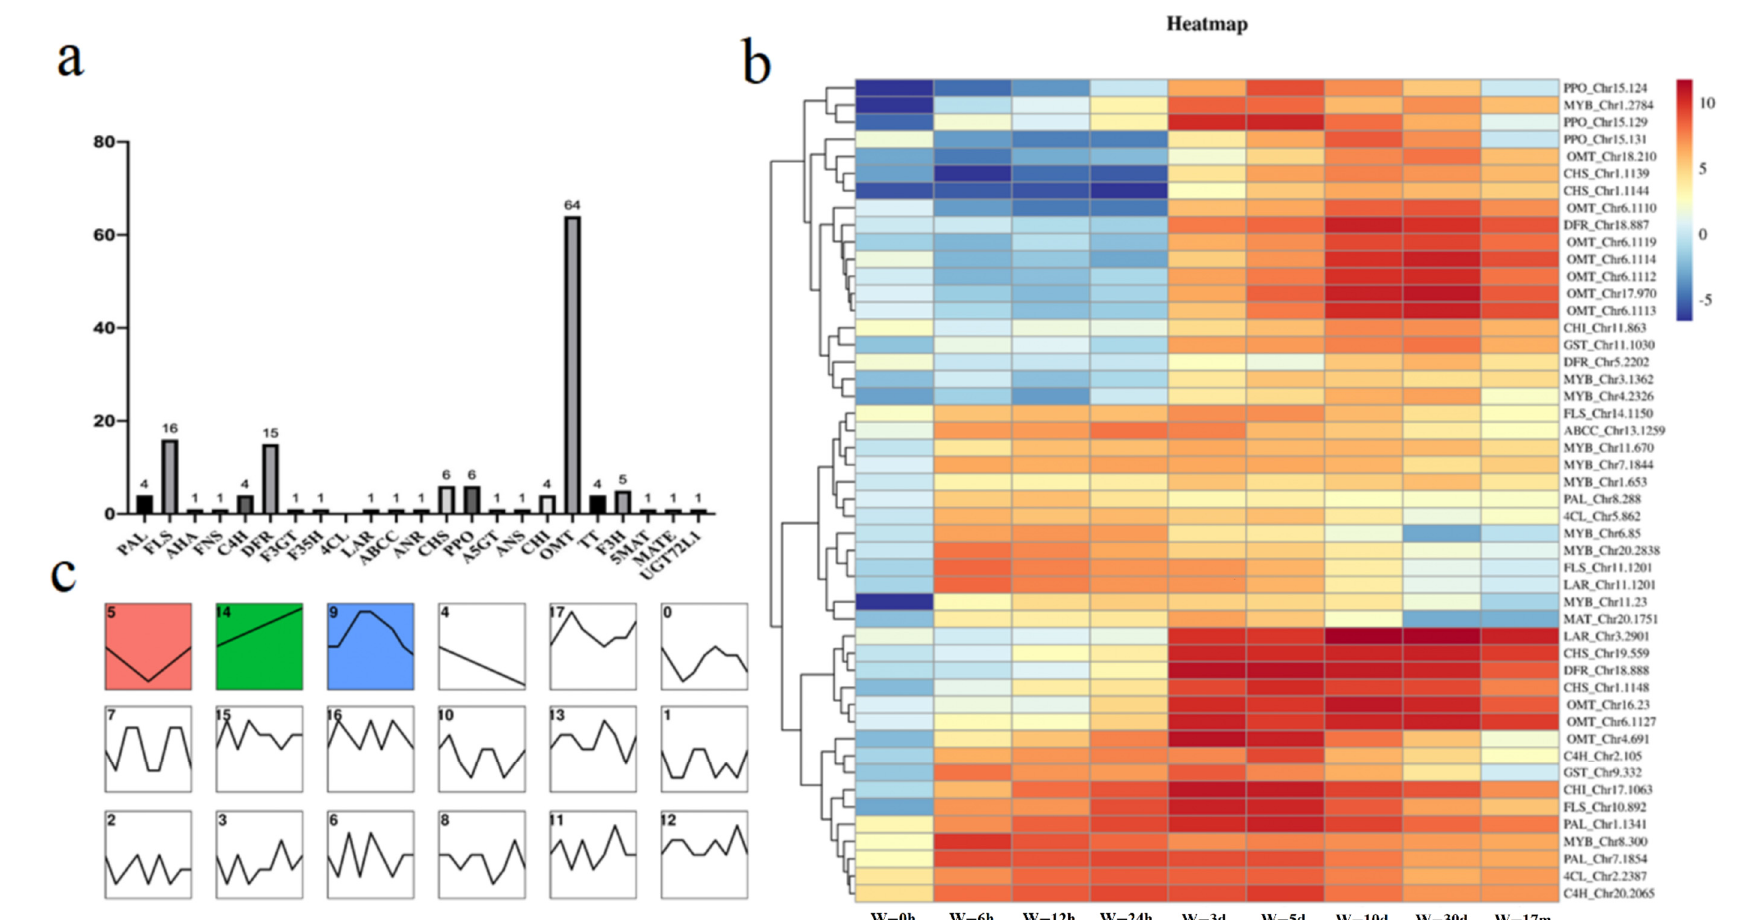
Figure 6. Flavonoid biosynthesis profile at genetic level in D. cochinchinensis after wounding: ( a ) types of annotated genes in flavonoid biosynthesis; ( b ) trend analysis result of genes related to flavonoid biosynthesis; ( c ) heatmap and clustering of wound-induced genes related to flavonoid biosynthesis.